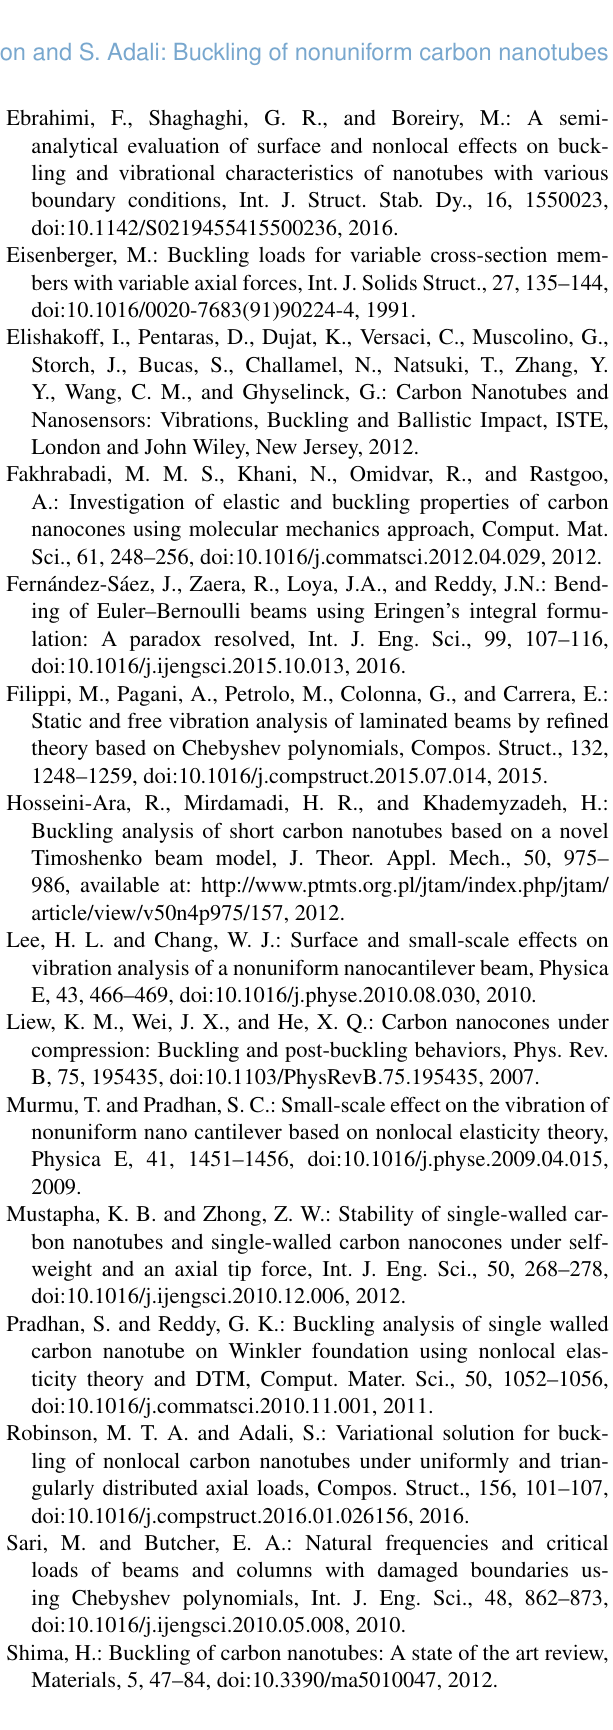
Figure 8. Contour plot of q 2 with respect to β and p with µ = 0 . 1, (a) CC, (b) CF.